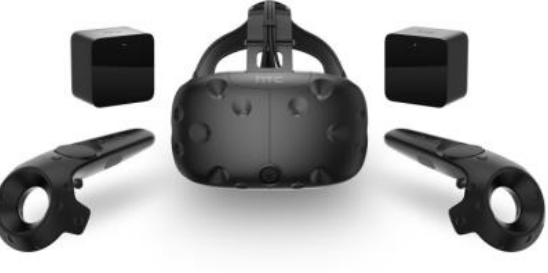
Fig. 7. The components of the Virtual Reality System HTC